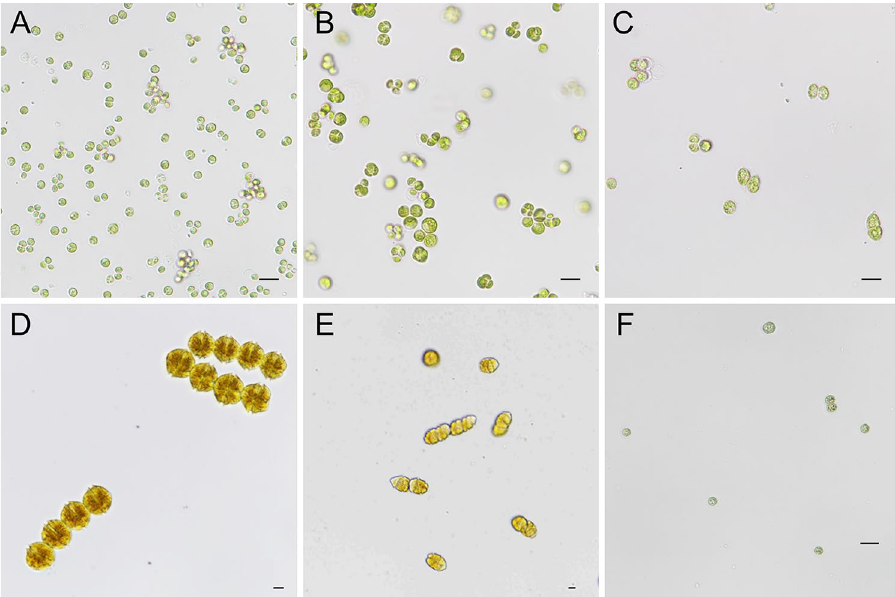
Figure 5. Microscopy images of algal strains. ( A ) Chlorella sorokiniana , ( B ) Parachlorella kessleri , ( C ) Scenedesmus deserticola , ( D ) Alexandrium tamarense , ( E ) Cochlodinium polykricoides , ( F ) Microcystis aeruginosa